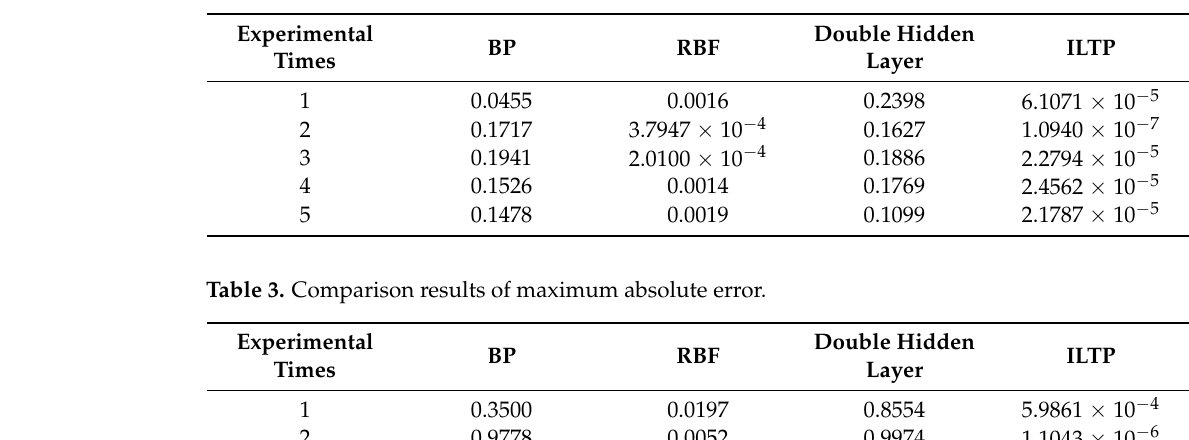
Figure 11. Three-dimensional Lorenz error iterative convergence curve. The blue line represents the absolute error value curve, and the blue circle represents the absolute error value.